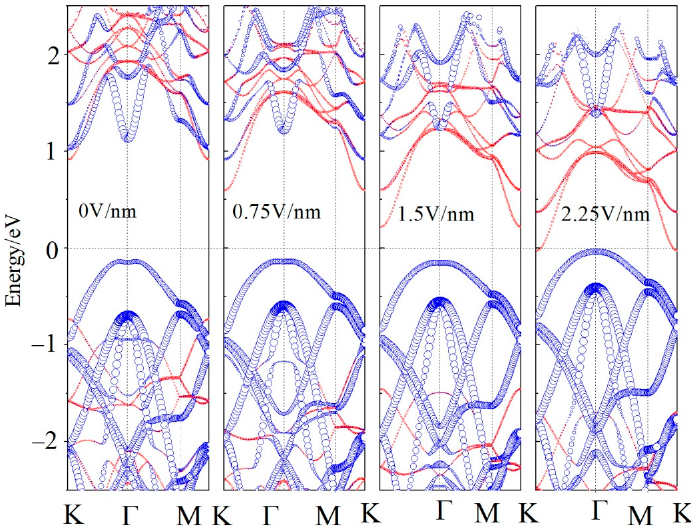
Figure 4. The band structure of the arsenene/WS 2 heterostructure under various external electric fields. The blue and red lines represent the bands of arsenene and WS 2 , respectively.